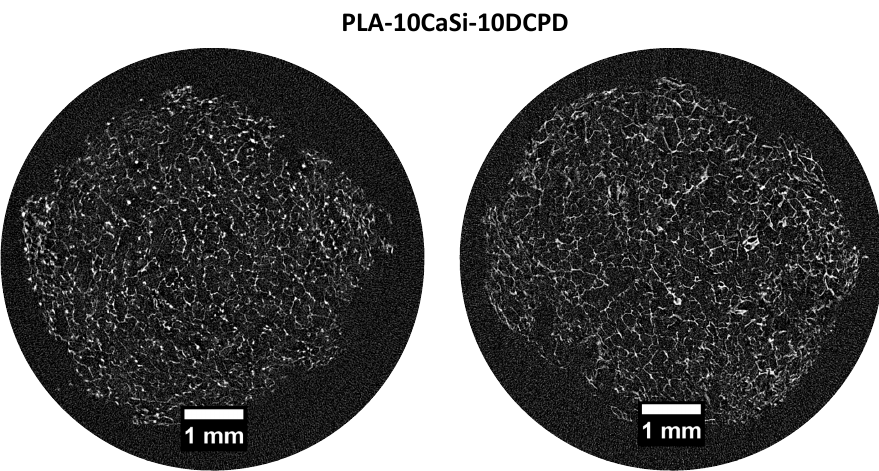
Figure 5. Micro-CT scan of 2 random slices of PLA-10CaSi-10DCPD reveals a highly porous regular “honey-comb like structure”, similar to the other mineral-doped scaffolds.